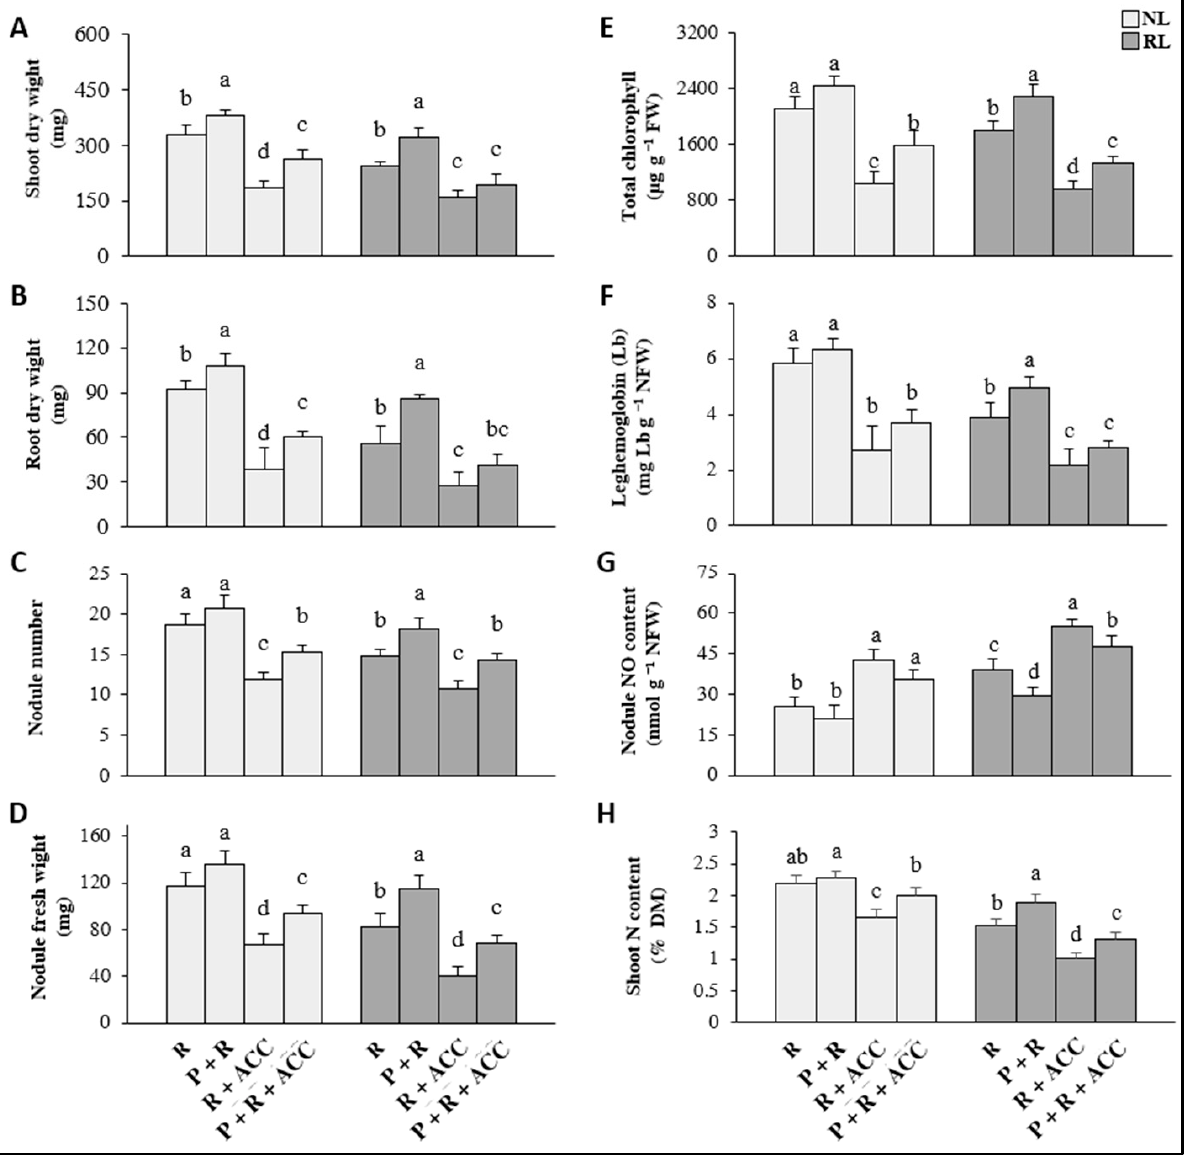
Figure 3. Effect of inoculation with P. thivervalensis strain T124 and exogenous ACC on dry weight ( A , B ), nodulation status ( C , D ), leaves total chlorophyll ( E ), nodule leghemoglobin content ( F ) nodule NO content ( G ) and shoot N content ( H ) of clover plants inoculated with the efficient R. leguminosarum strain T618 under normal and reduced light conditions. (R: inoculated with R. leguminosarum strain T618; P: inoculated with P. thivervalensis strain T124; ACC, exogenous ACC; NL, Normal light condition; RL, Reduced light condition. Treatment columns in each light condition followed by different letters are significantly different ( p < 0.05). The error bar represents the standard error of the mean ( n =